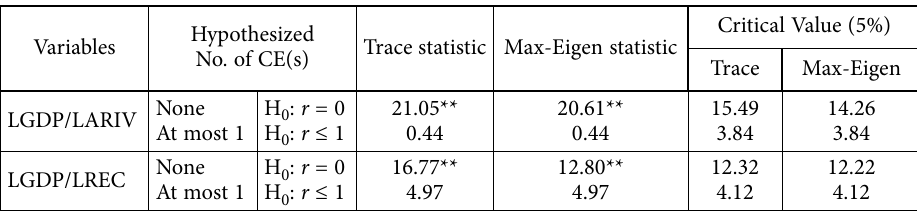
Table 4. Cointegration test results (source: own calculations using Eviews 9) Hypothesized Trace statistic Max-Eigen Variables No. of CE(s)